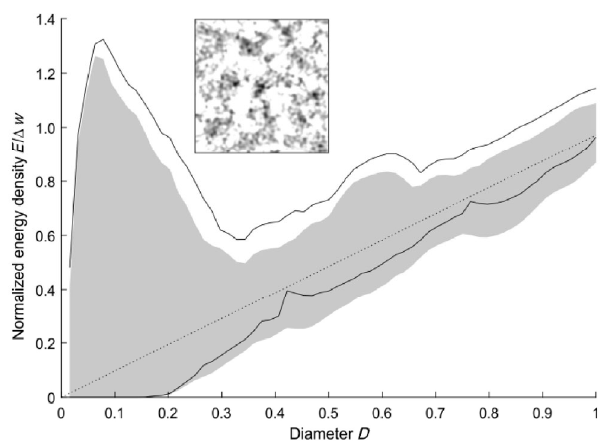
Fig. 6 Illustration of the energy density curve at high forces. Large diameters of probe the circle necessarily lead to large values of E . The mean pressure was chosen as 5   p , other parameters as in Fig.